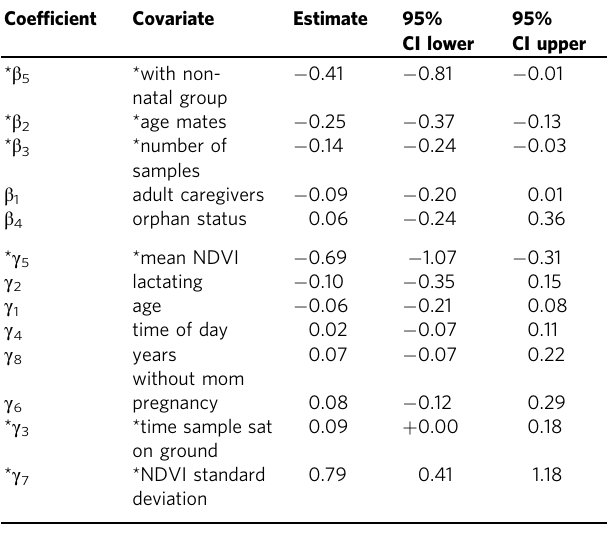
Table 1 Bayesian hierarchical regression model results, showing estimated coef fi cients relating variables to fecal glucocorticoid metabolite concentrations, from 37 sampled elephants ( n = 496 dung samples).